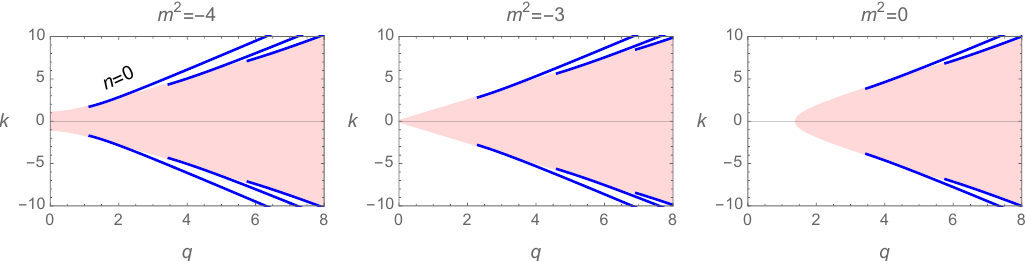
Figure 3 . Phase diagram for the standard quantization. We take K = 1 , and the vertical axis is √ k ≡ λ − 1 . The solid lines correspond to zero modes. The region with IR instability is shaded, and will move to the right as we increase m 2 . In the right plot, the tip of the shaded region corresponds to a bifurcating critical point at k = 0 .